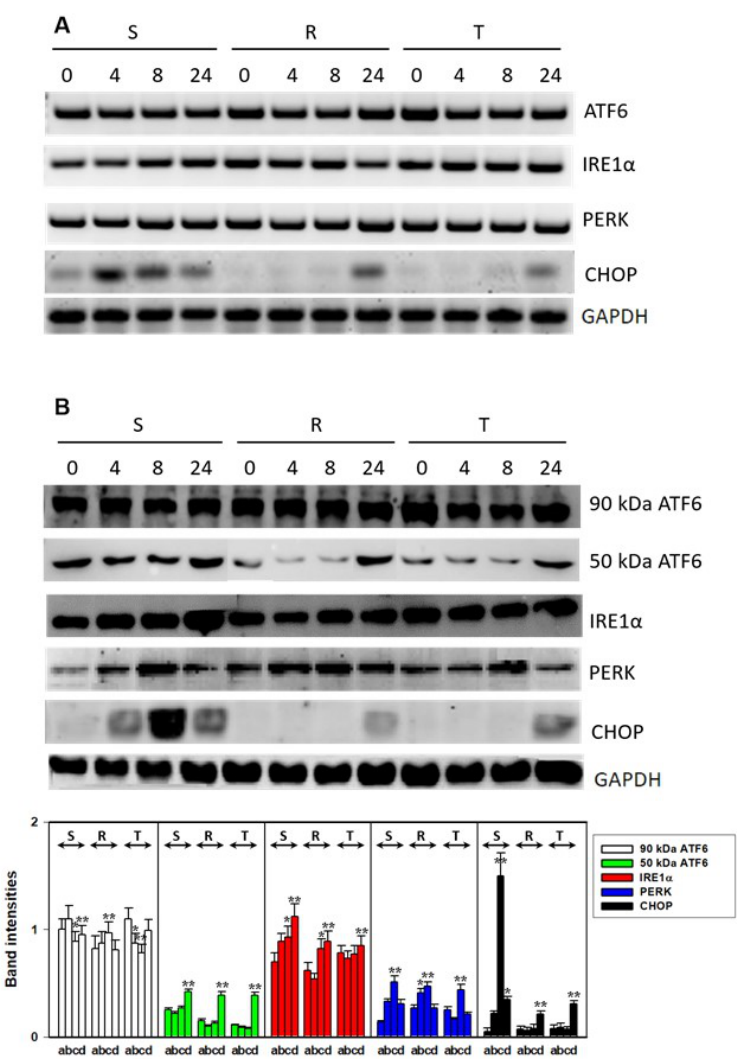
Figure 6. Detection of ER stress receptors / stress markers in S, R, and T cells after 4-, 8-, and 24-h incubation in the presence or absence of tunicamycin: ( A ) RT-PCR analysis of the ER stress-related genes ATF6, IRE1 α , PERK, and CHOP. GAPDH expression was used as an internal control. Data are representative of three independent measurements. ( B ) Western blot analysis of the ER stress-related proteins ATF6 (and its cleaved fragment), IRE1 α , and PERK and the ER-stress regulator / marker CHOP. GAPDH was used as a housekeeping protein. Protein bands were quantified by densitometry, and data in bottom column plots were normalized to GAPDH and are expressed as the mean ± S.E.M. of three independent measurements. Cells were incubated in the presence of 0.1 µ M tunicamycin for 0 (a), 4 (b), 8 (c), and 24 (d). Significance: Data di ff er from values obtained in cells that were not incubated